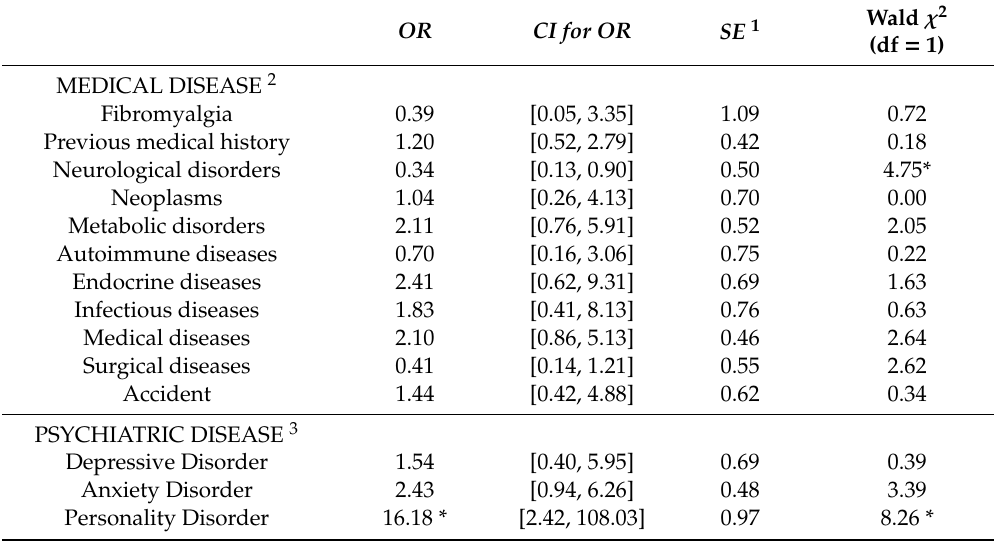
Table 5. Multiple logistic regression predicting the probability of receiving a Somatic Symptoms Disorder (SSD) diagnosis from medical and psychiatric diseases.